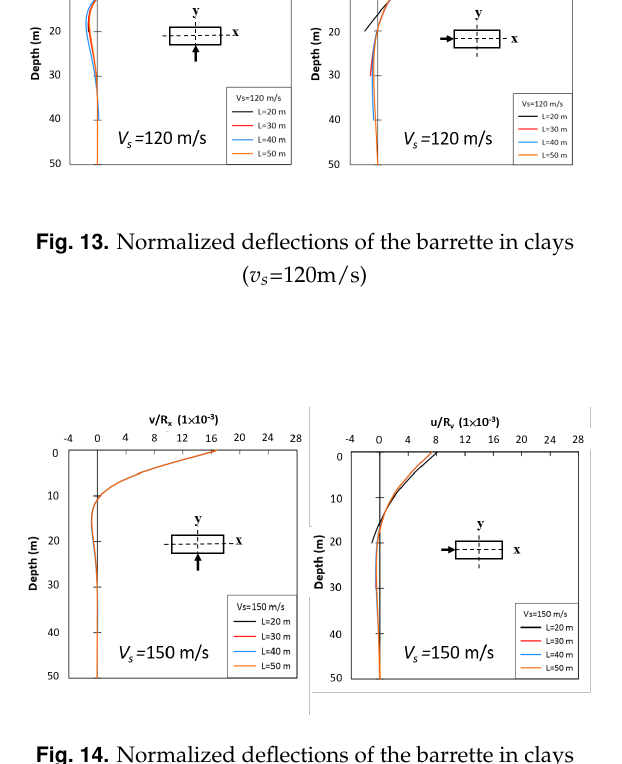
Fig. 16. Normalized deflections of the barrette in sands ( v s